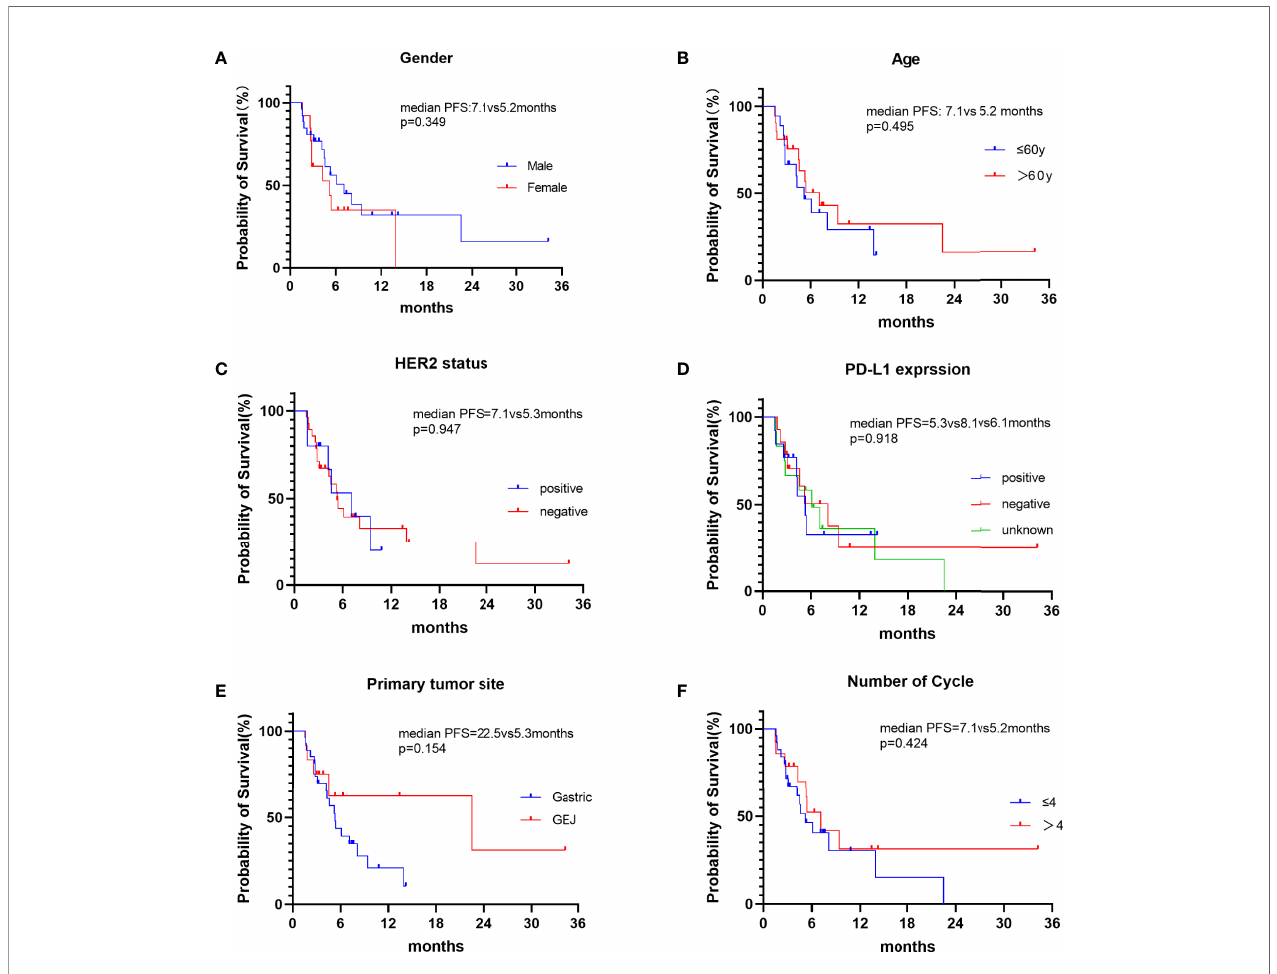
FIGURE 2 | Kaplan-Meier curves of PFS in different subgroups of patients. (A) PFS in patients of different gender. (B) PFS of patients ≤ 60y and >60y. (C) PFS of HER2-positive and HER2-negative patients. (D) PFS of different PD-L1 expression status. (E) PFS of different primary tumor sites. (F) PFS of different chemoimmunotherapy cycles: ≤ 4 cycles and >4